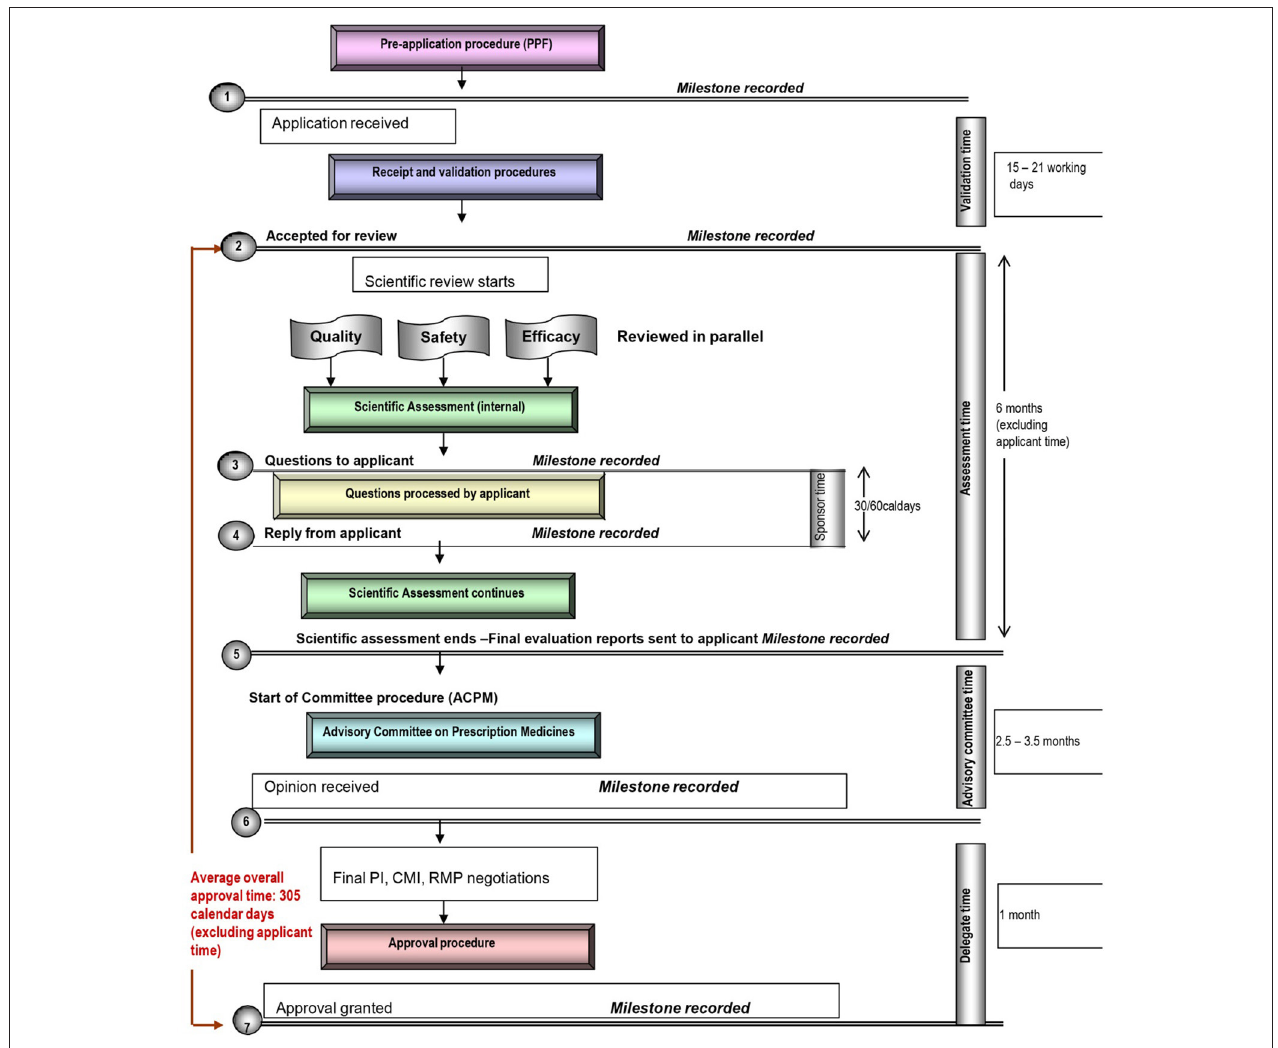
FIGURE 2 | Registration process map for